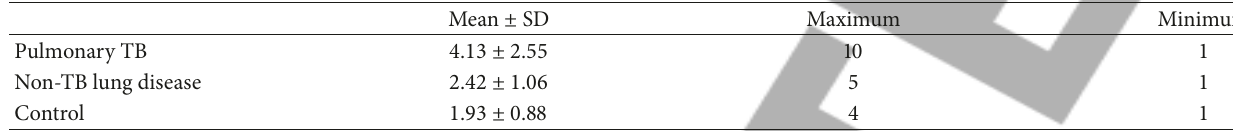
Table 2: Mean and SD of ADA level in BAL of patients in 3 study